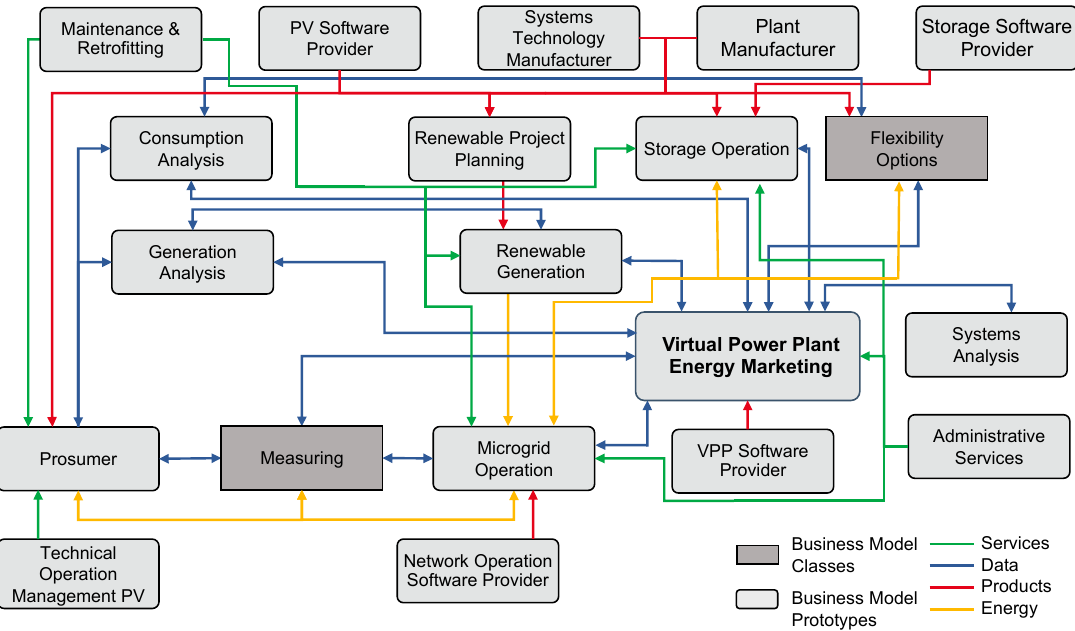
Figure 9. Value creation network of a virtual power plant (VPP).